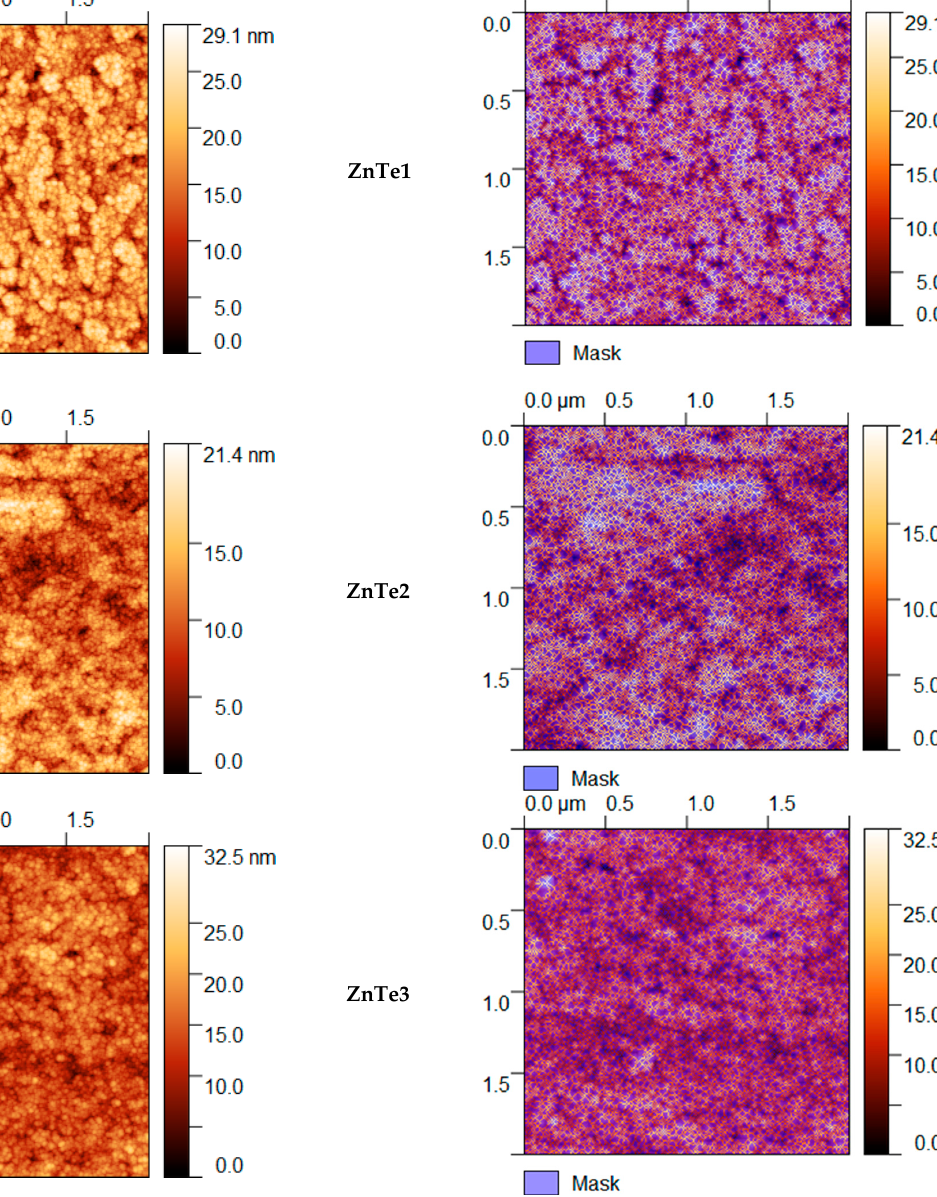
Figure 3. AFM characterization of ZnTe thin films with different thicknesses. The calculated majoritarian specific parameter size grains are presented in Table 1. These were chosen based on statistical distributions presented in Figures 4–8. The calculus algorithms